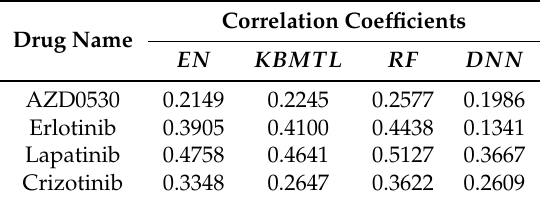
Table 1. Prediction performance in the form of correlation coefficients between actual and predicted drug sensitivity for Elastic Net (EN), Kernelized Bayesian Multitask Learning (KBMTL), Random Forest (RF) and Deep Neural Network (DNN) for four drugs in the Cancer Cell Line Encyclopedia (CCLE)